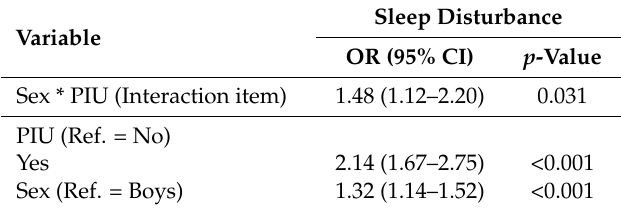
Table 3. Associations of the interaction item with sleep disturbance: a two-level multivariate logistic regression model *.